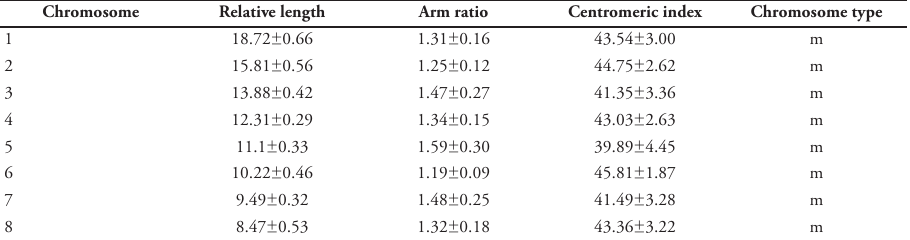
Table 3. Karyotype parameters (mean values and standard deviations) of Dugesia verrucula ; m: metacentric. Chromosome Relative length Arm ratio Centromeric index Chromosome